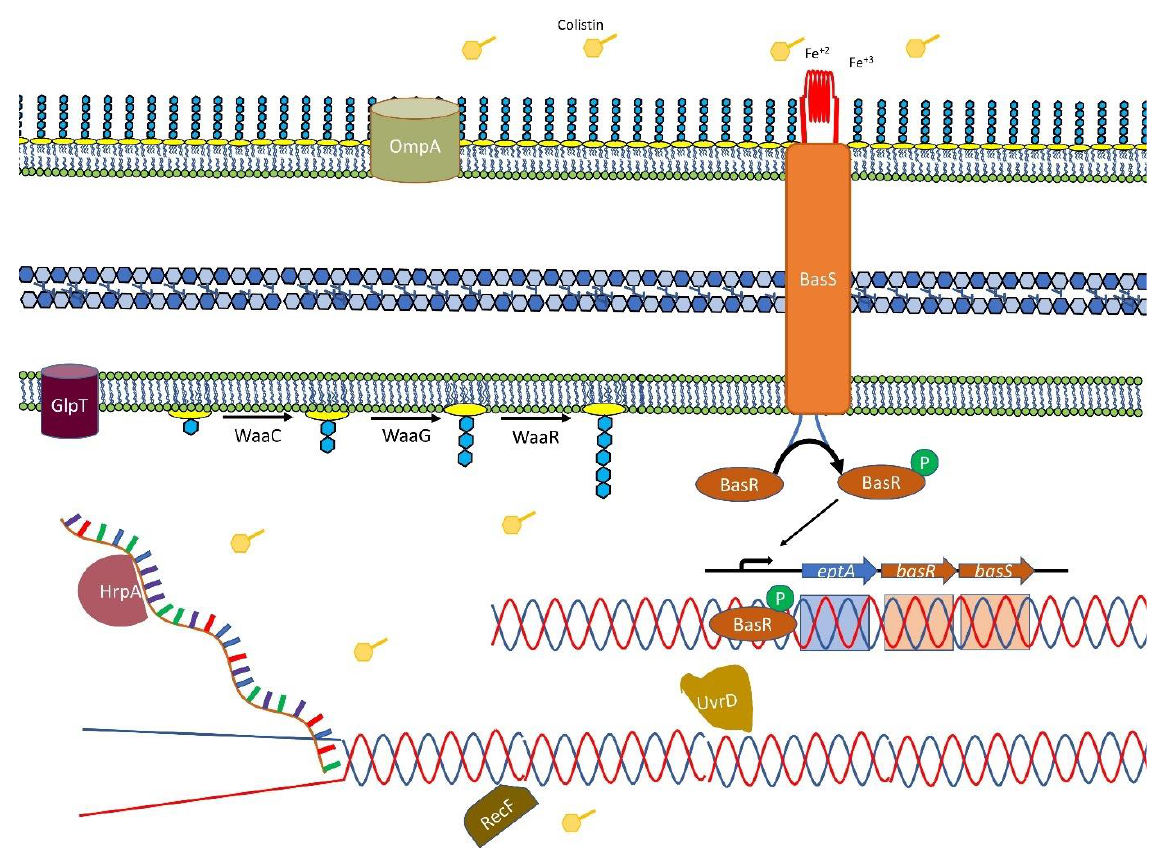
Figure 3. Pathways implicated in LPS modification and colistin resistance. This illustration shows how the two-component system BasSR is activated by iron or colistin, which then activates the etpA and basSR operon. Overexpression of basSR leads to modification of the LPS moiety via addition of the positively charged molecules L-Ara4-N and PEtN. The LPS biosynthesis pathway (waa) genes are protected under colistin stress, indicating an essential role. The illustration depicts UvrD and RecF and RNA helicase HrpA representing DNA and RNA associated proteins important in colistin